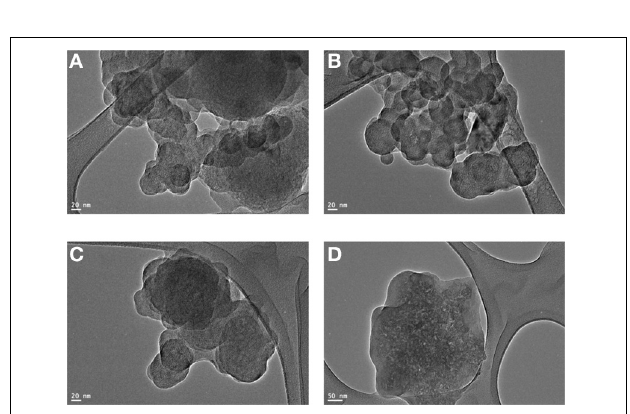
Figure 5 | SEM micrograph of (A). Neat AECE 1 , (B) . 10% POSS-AECE 1 , (C) . AECE 2 , (D) . 10% POSS-AECE 2 , (E) . Neat AECE 3 , (F) . 10% POSS-AECE 3 , (G) . Neat AECE 4 and (H) . 10% POSS-AECE 4 .